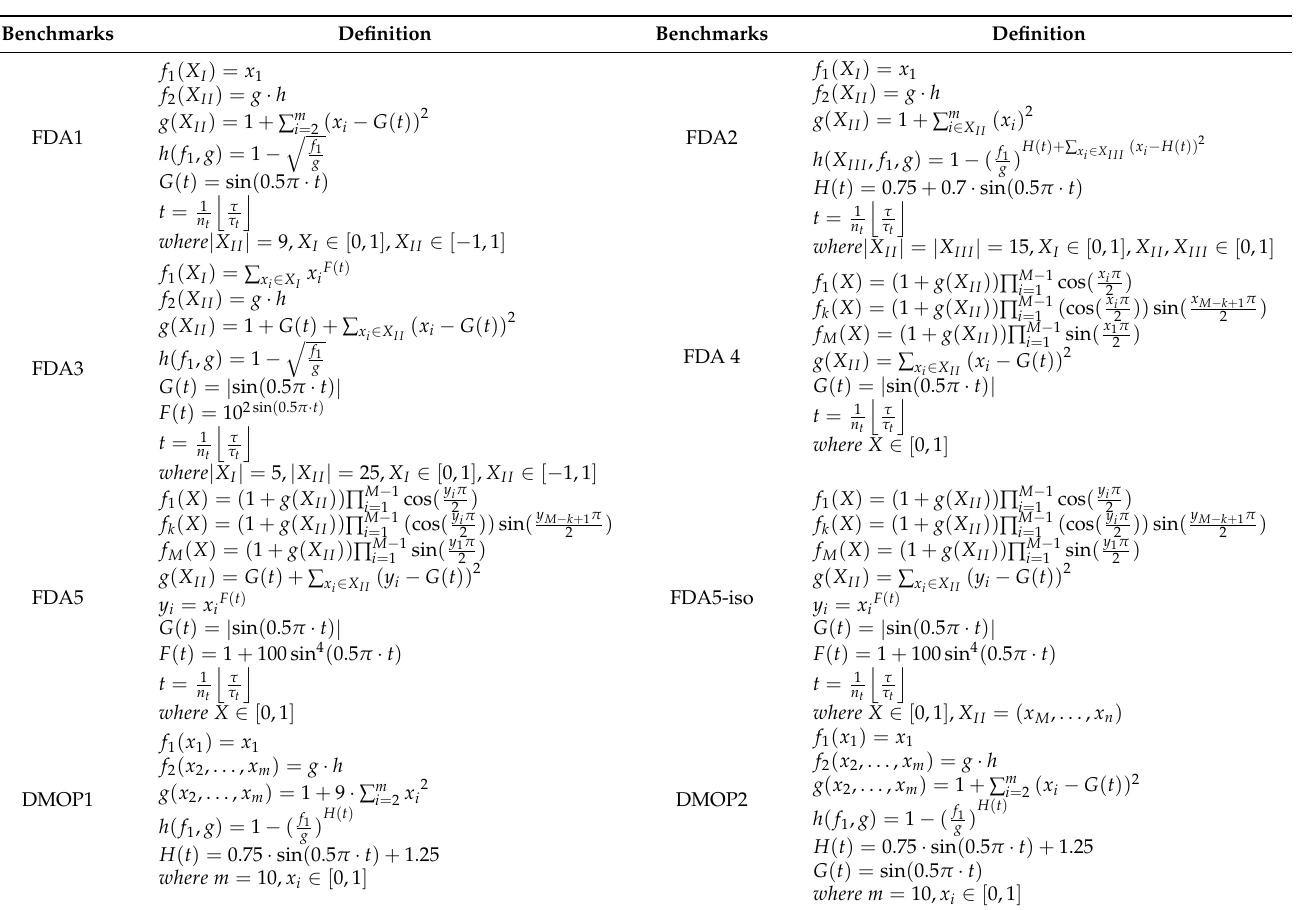
Table 3. The formula definition of standard